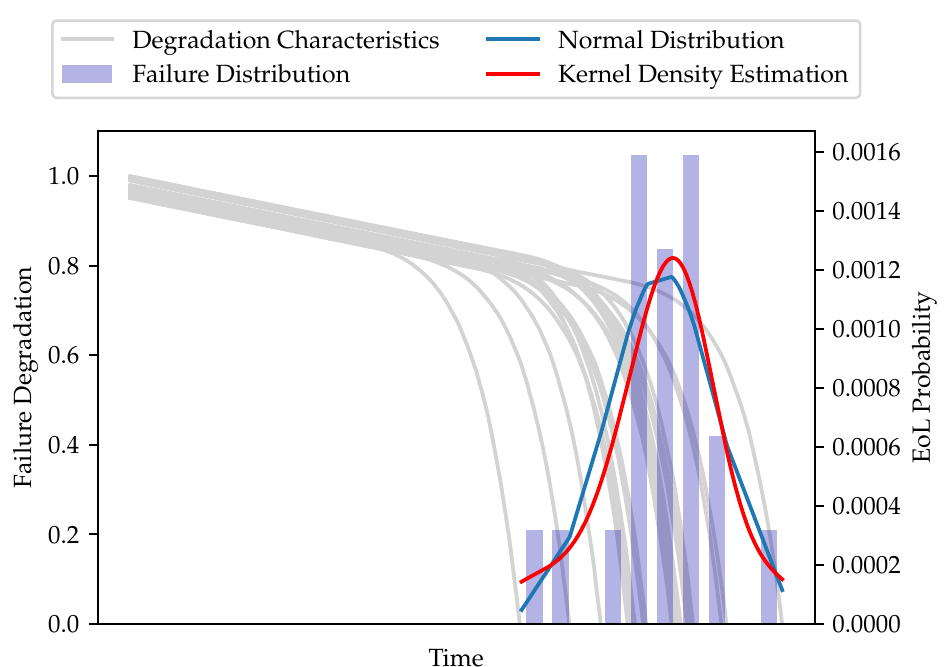
Figure 5. Degradation progression and failure distribution of hover coil failure. The gray slopes show the time course of the degradation. To avoid confusion between simulation time and actual time, the exact indication of the time unit on the x-axis